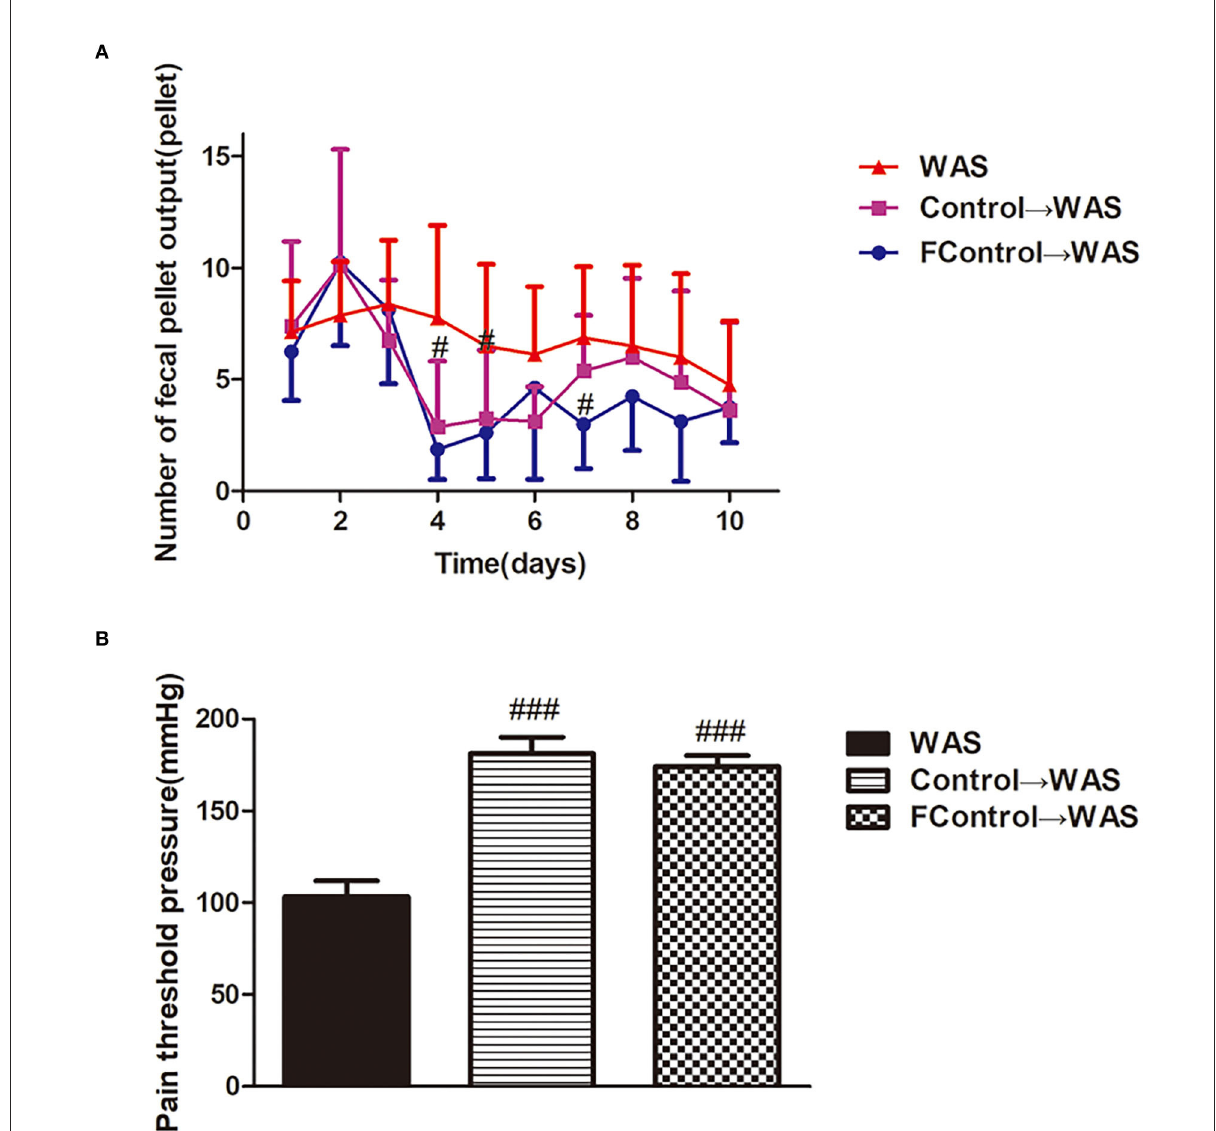
FIGURE4 Effect of filtered FML on IBS-like symptoms of WAS rats. (A) Fecal pellet numbers output of rats every day. (B) PT in rats (All results are expressed as mean ± SE n = 8/group, # P < 0.05 vs. WAS, ### P < 0.001 vs. WAS).